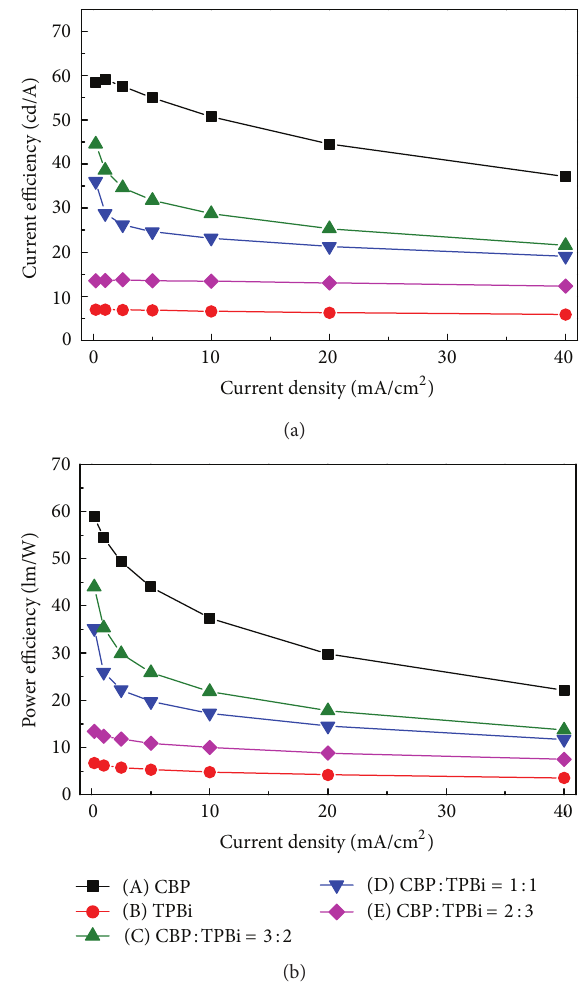
Figure 4: The relationships of (a) current efficiency versus cur- rent density and (b) power efficiency versus current density of HWOLEDs (Devices A, B, C, D, and